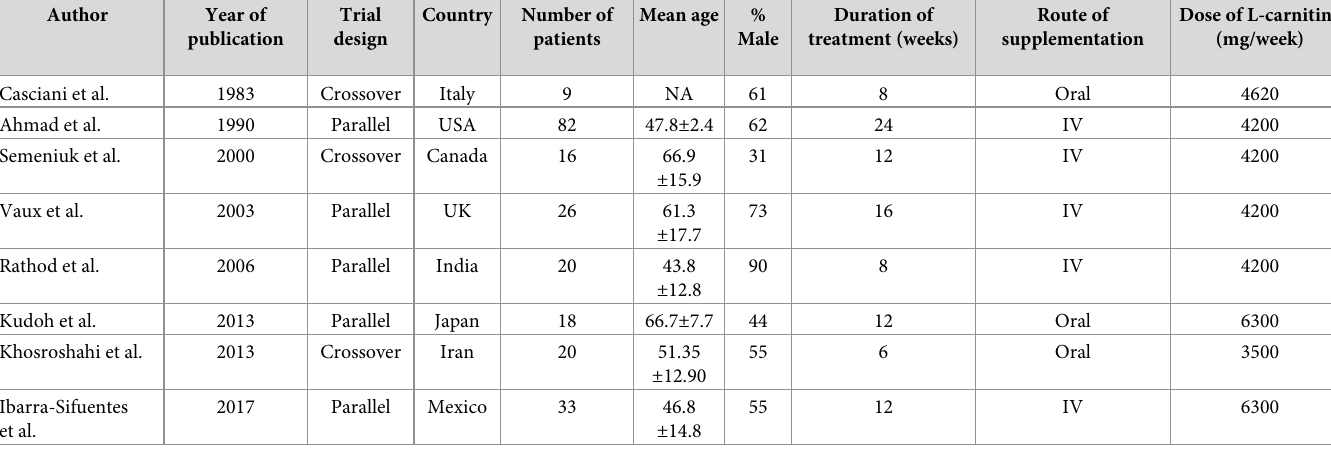
Table 1. Main characteristics of studies included in the meta-analysis of the effects of L-carnitine on dialysis-related hypotension.